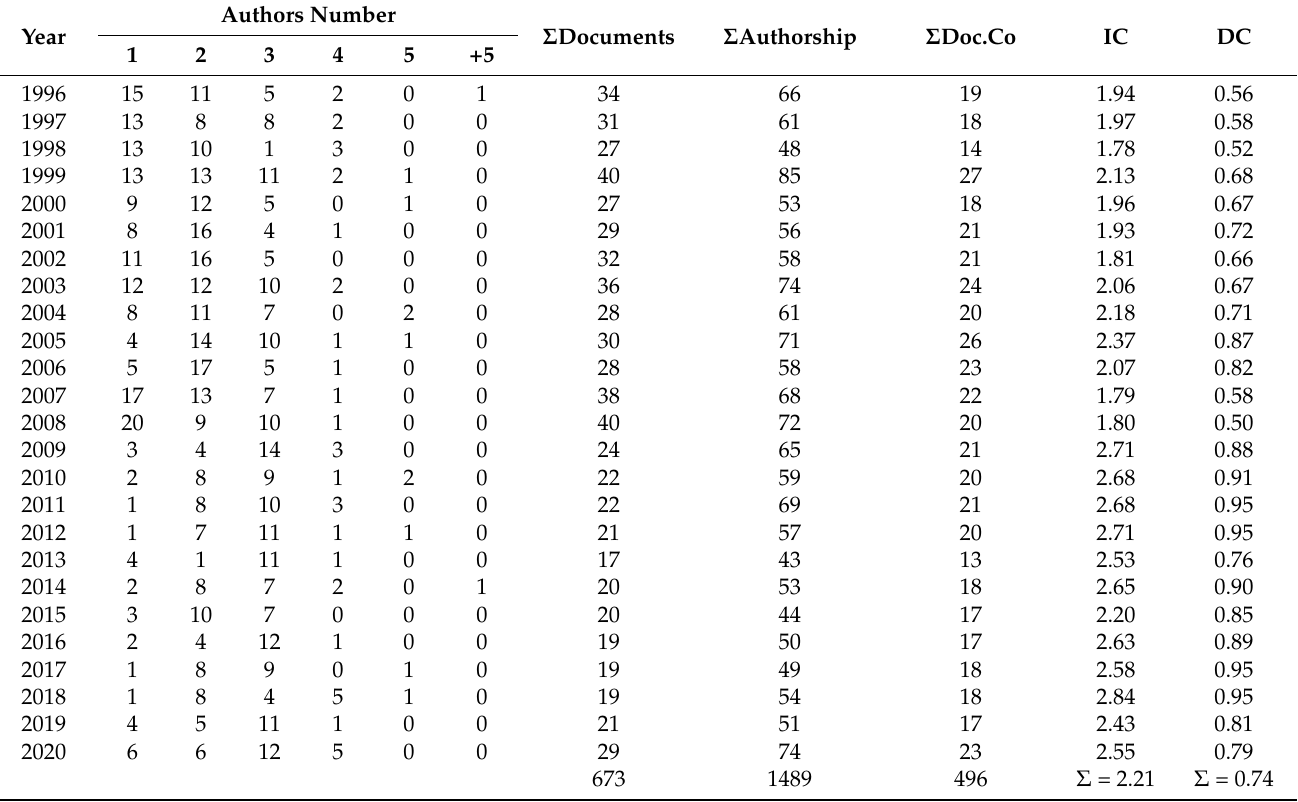
Table 7. Index and Degree of Collaboration of the authors who publish in SJFA.